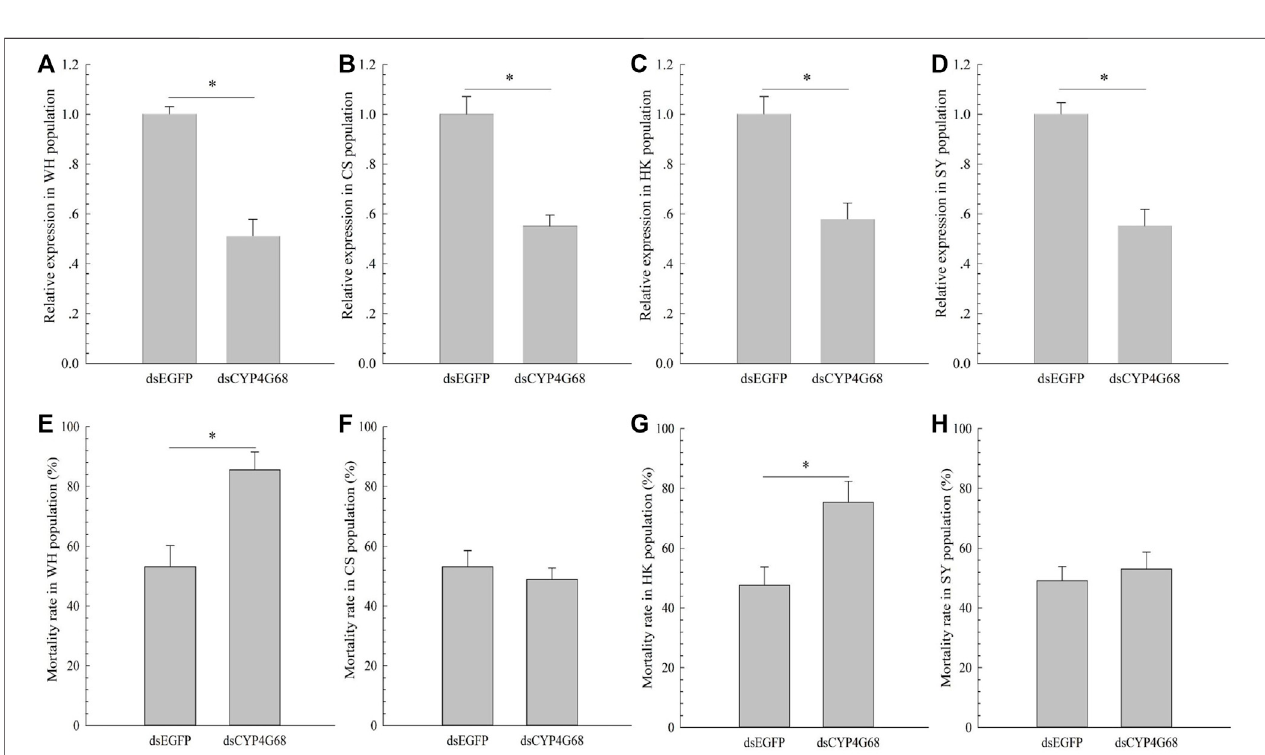
FIGURE4| EffectsofdsCYP4G68 on theexpression of CYP4G68 inpopulationsWH (A) ,CS (B) ,HK (C) , andSY (D) .Effects ofsilencing CYP4G68 on resistance to cyantraniliprole in populations WH (E) , CS (F) , HK (G) , and SY (H) .